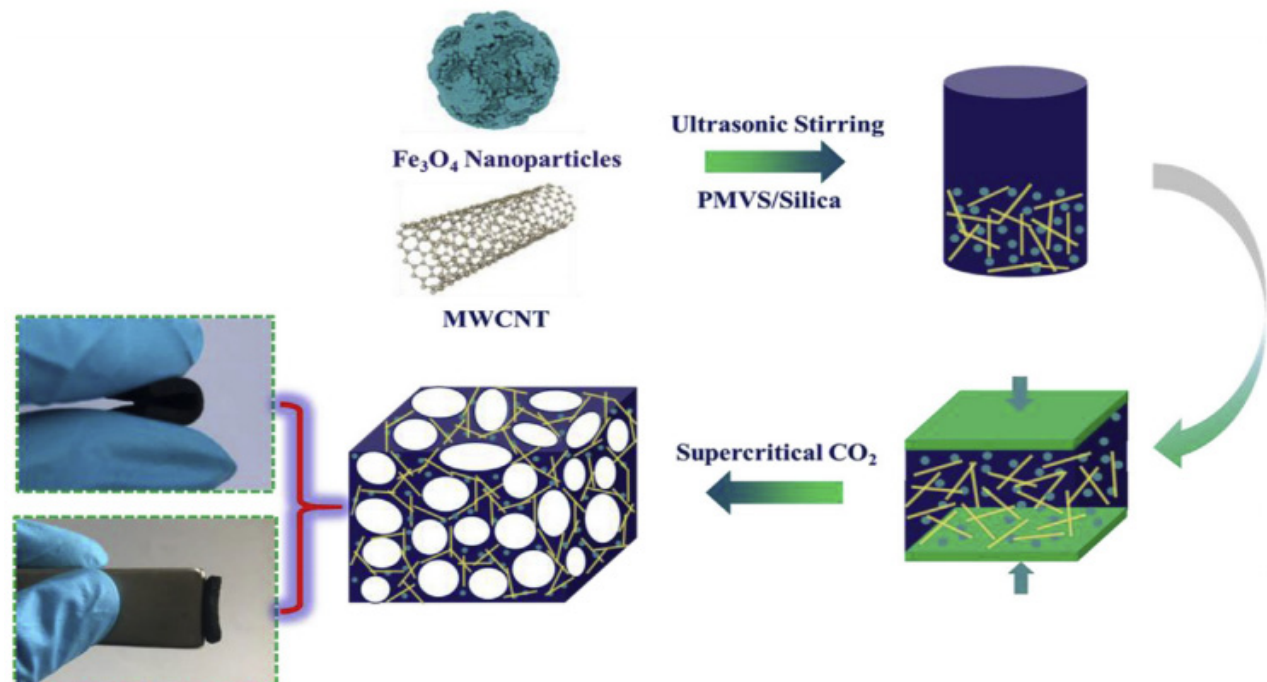
Figure 6. Schematic for the preparation of VMQ/MWCNTs/Fe3O4 nanocomposite foams. Repro- duced with permission from [106]. Copyright 2019, Elsevier Ltd.